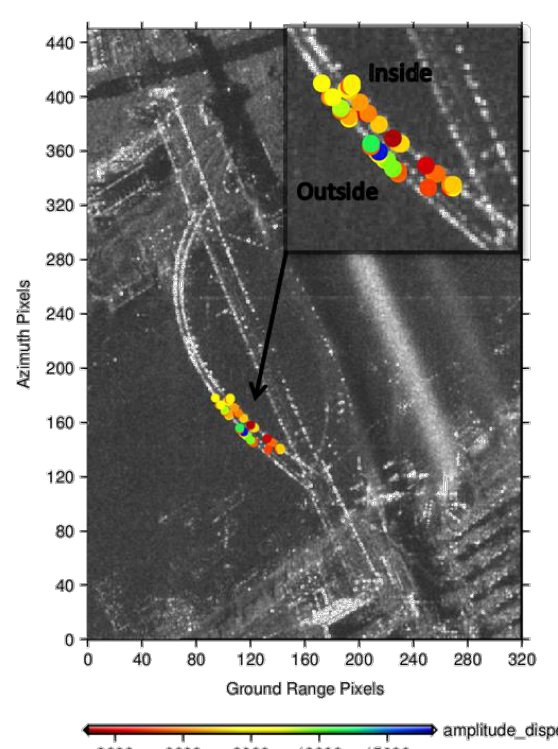
Figure 8. Amplitude dispersion of part bridge arc (Note that